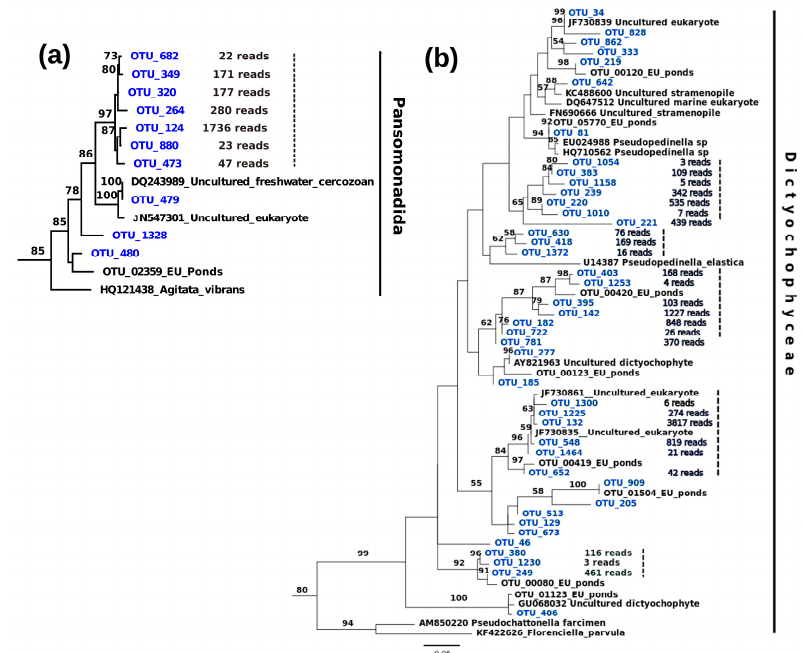
Figure 6. ( a ) Potential species flock in Pansomonadida (Rhizaria), which includes 7 OTUs differing > 10% from any known DNA sequence; ( b ) Potential species flocks in Dictyochophyceae (see full tree